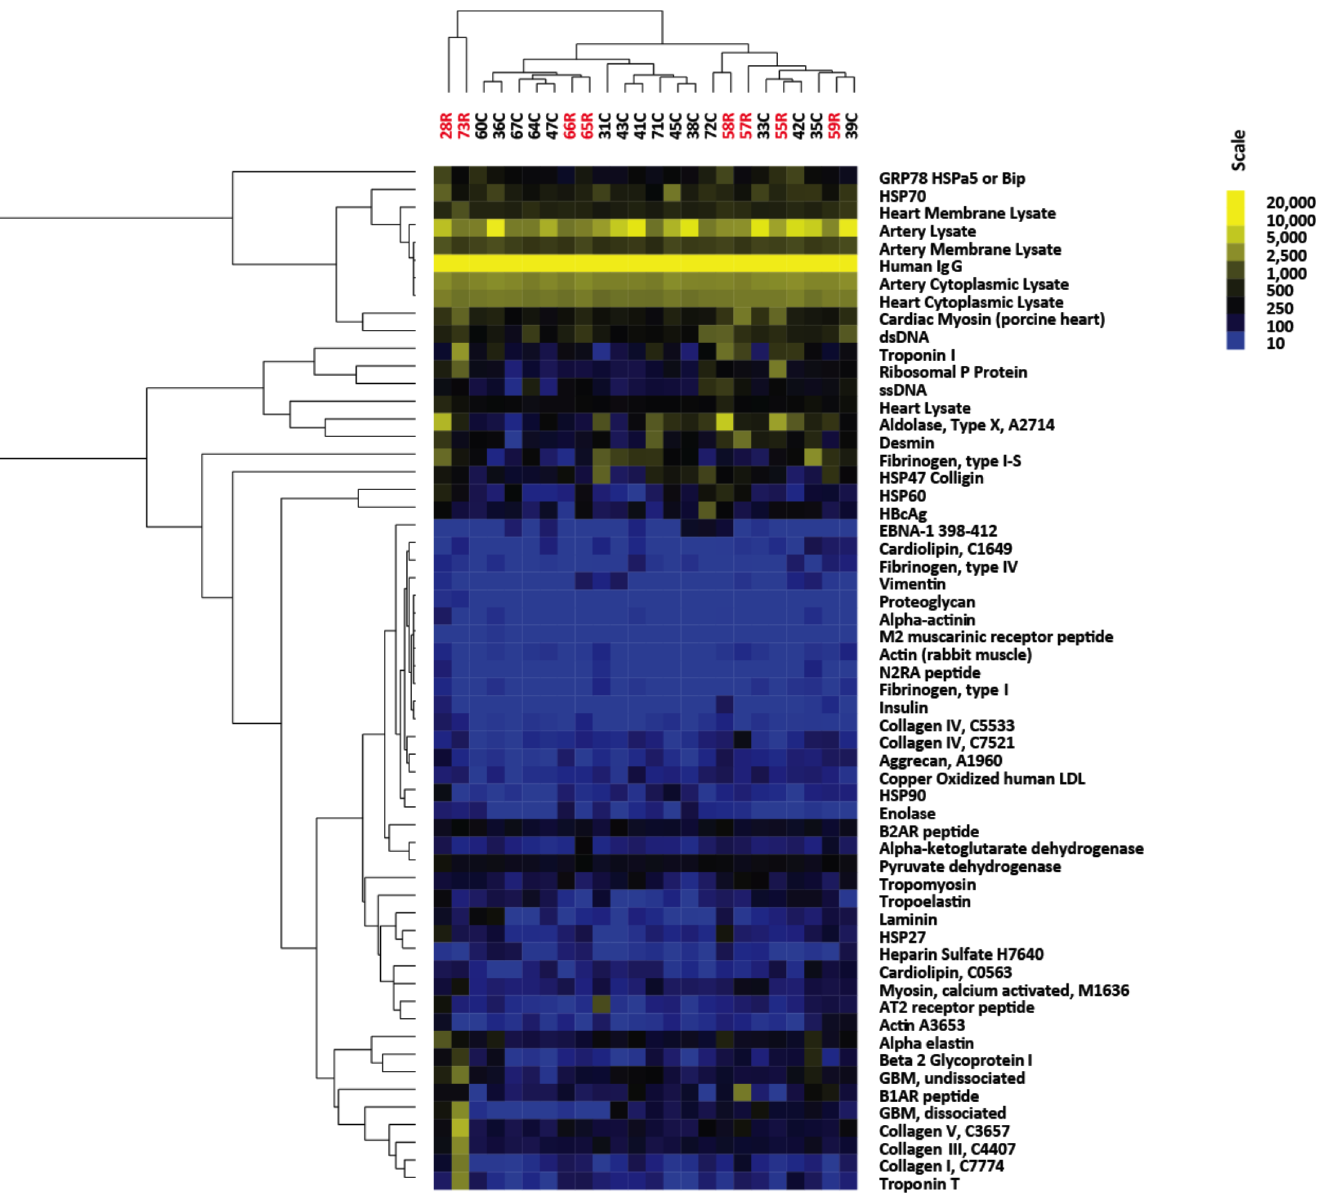
Fig 3. Heatmap of all autoantibody reactivities in pre-transplant serum from rejectors and non-rejectors. Yellow indicates higher reactivity, whereas blue indicates lower reactivity as shown in scale. Recipients who experienced rejection are in labeled in red and non-rejectors are labeled in black. Results are representative of two independent array